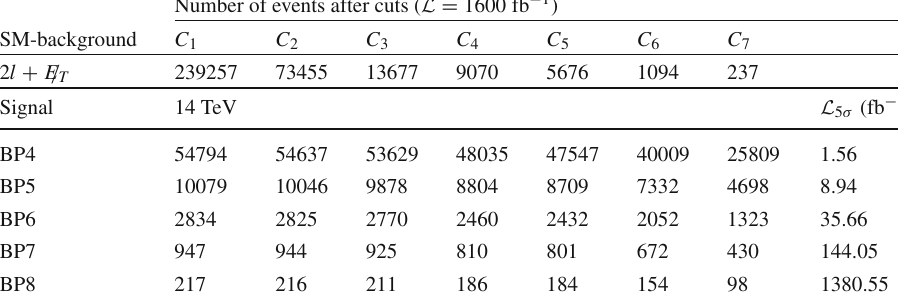
Table 5 The cut-flow for signal and backgrounds along with the required integrated luminosity to achieve 5 σ significance for the μ + μ − → 2 l + E T / channel for BP4–BP8 at 14 TeV Muon collider